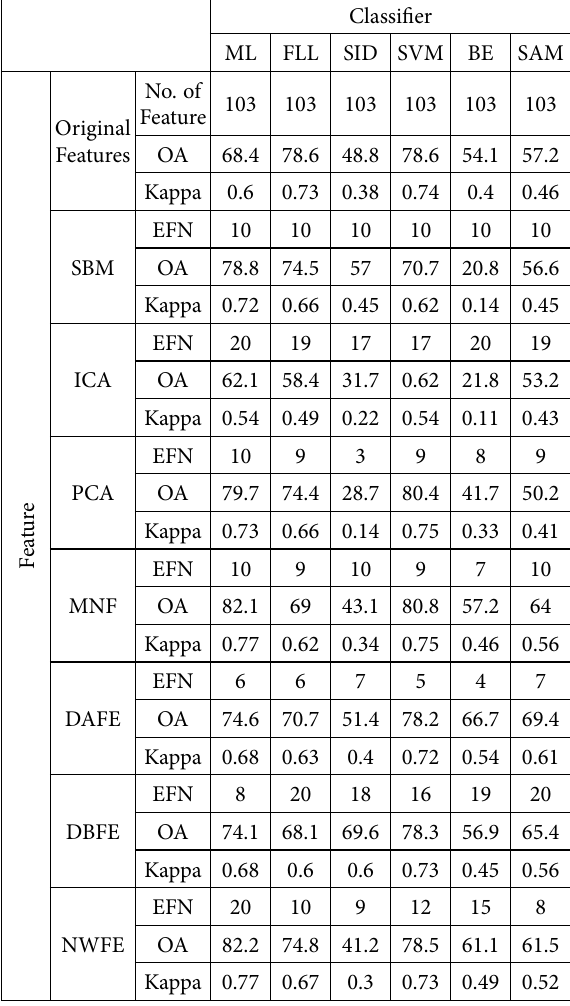
Table 1. Results of pixel-based classification